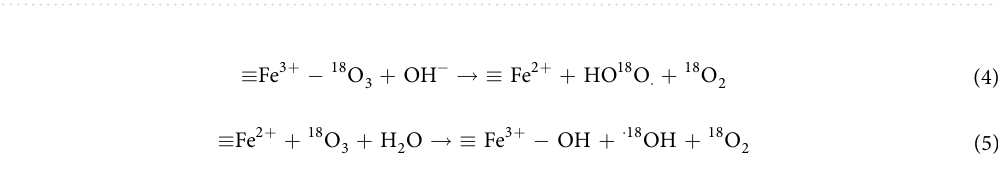
Figure 6. EPR signal in methanol dispersion for BMPO-HO 2 • /O 2 •− ( A ) and aqueous dispersion for BMPO- • OH ( B ) with